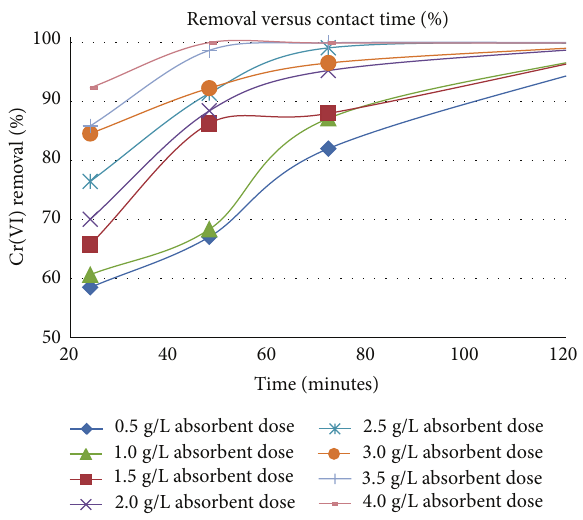
Figure 2: Effect of contact time on % Cr(VI) removal, pH 2.5, and initial Cr(VI) concentration of 40